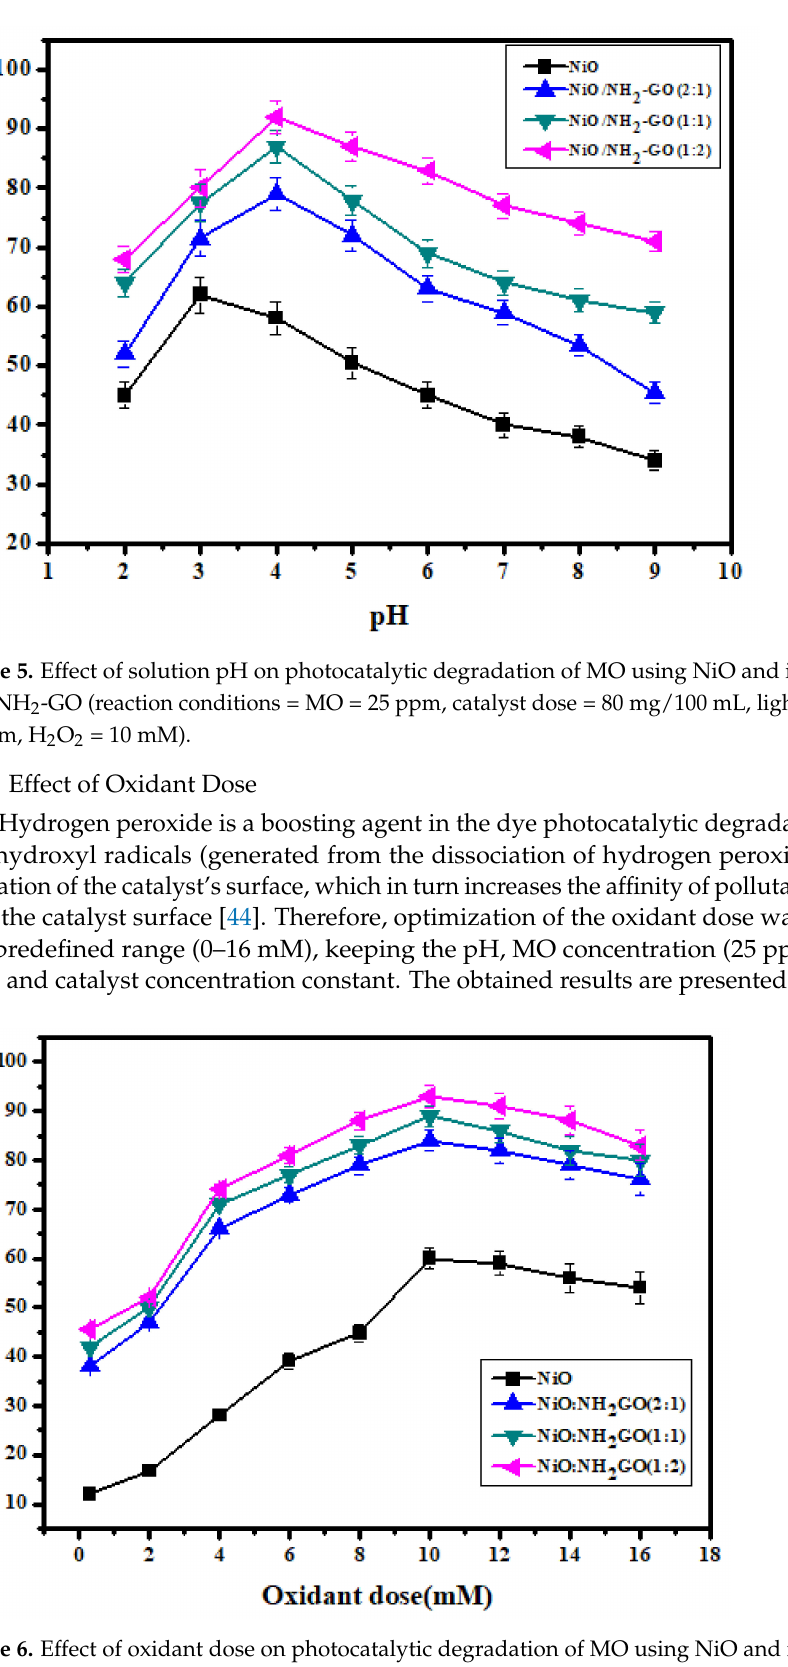
Figure 6. Effect of oxidant dose on photocatalytic degradation of MO using NiO and its composites with NH 2 -GO (reaction conditions = MO = 25 ppm, pH = 3 for NiO, NH 2 -GO, and NiO/NH 2 -GO92:1) and pH = 4 for other composites, light source = UV 254 nm, H 2 O 2 = 10